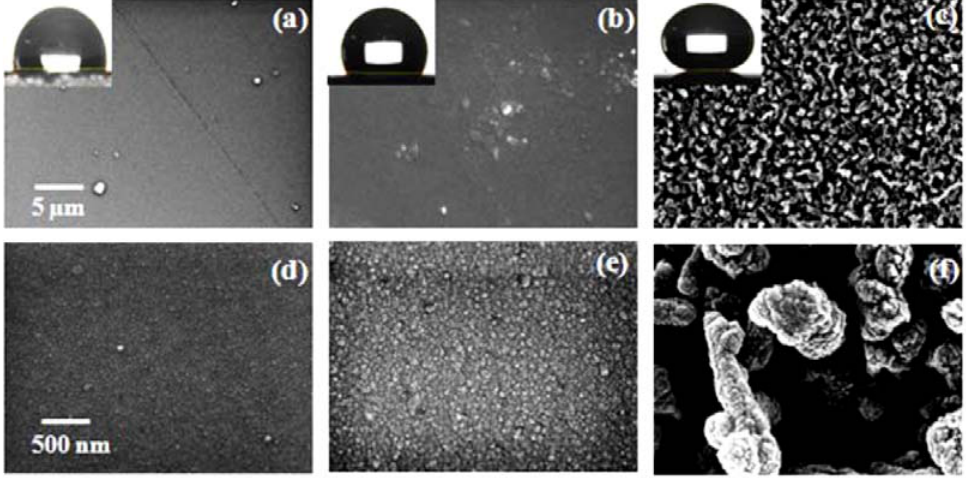
Figure 3. Field emission scanning electron microscopy images of: ( a ) sputter deposited Y O coating, ( b ) thermally oxidized Y-Y 2 3